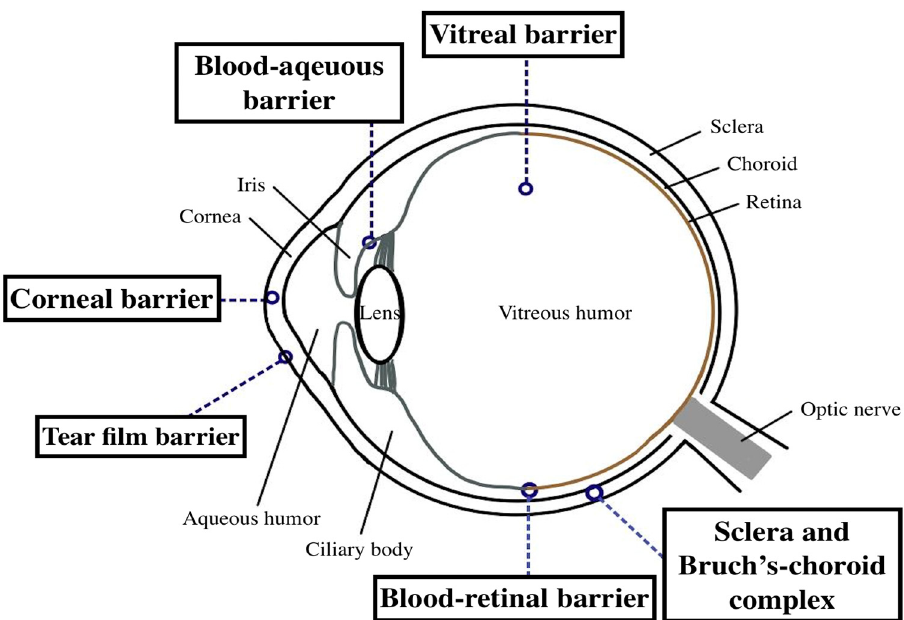
Figure 1. Schematic illustration of the ocular structure with the ocular barriers. The ocular barriers in the anterior segment include the tear film, cornea, and blood-aqueous barrier. The ocular barriers in the posterior segment include the vitreous humor, sclera, Bruch’s–choroid complex, and blood-retinal barrier.